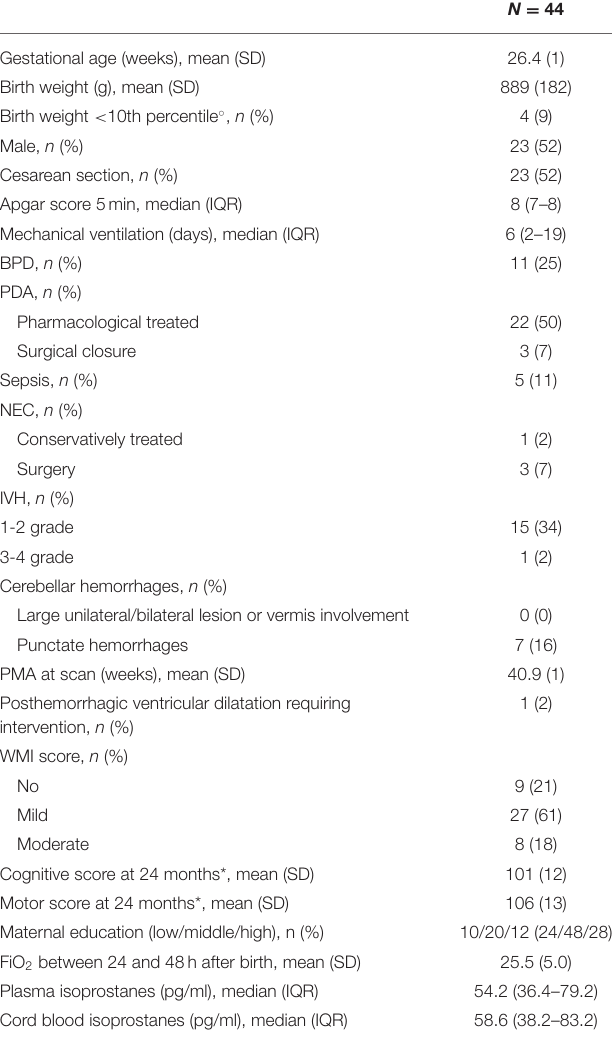
TABLE 1 | Clinical characteristics of studied